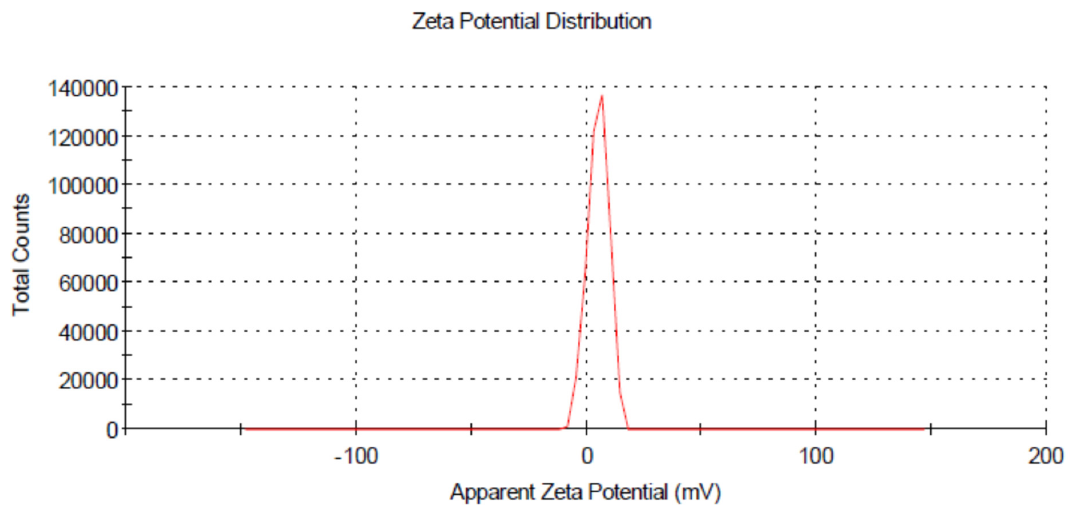
Figure 5. Z average size of Glycyrrhizic acid ammonium salt nanoparticles.